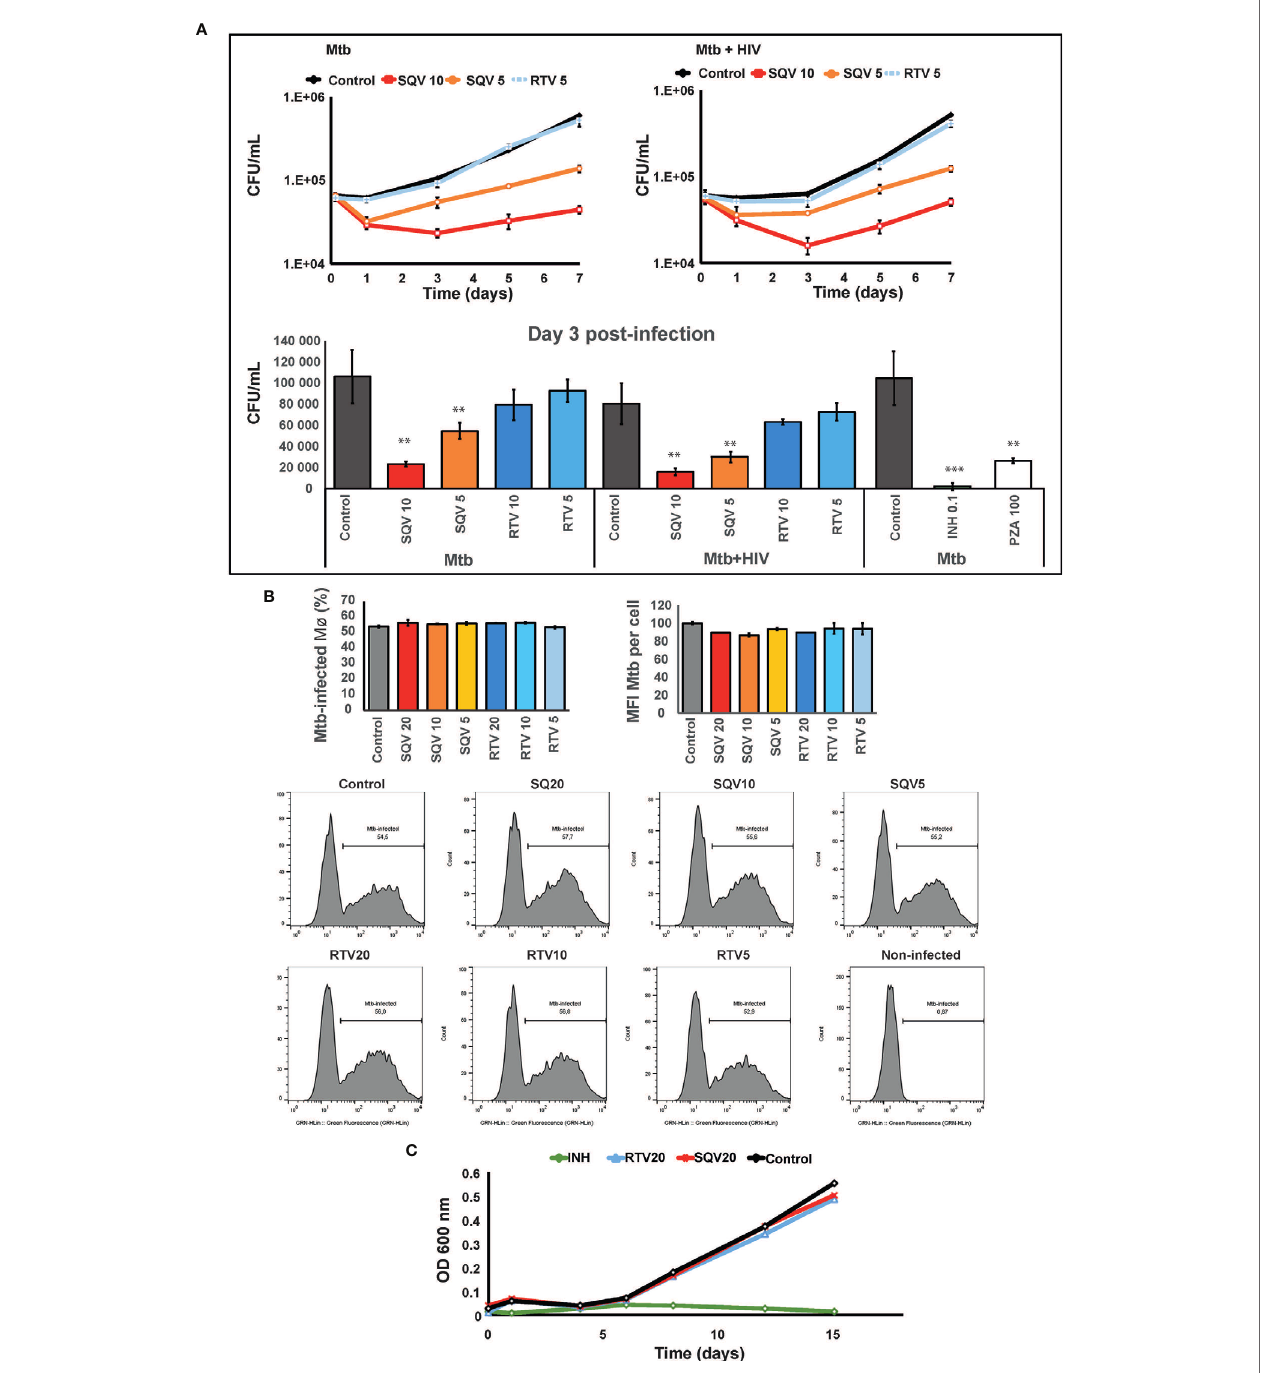
FIGURE 2 | SQV decreases the intracellular survival of Mycobacterium tuberculosis (Mtb). (A) Intracellular survival of Mtb during mono- or co-infection with HIV along 7 days of infection. Data represents colony forming units (CFU) of intracellular bacteria recovered from Mø treated with the PI or DMSO control. Culture medium was changed on day 3 p.i. without addition of fresh PIs. Values depict mean CFU representative of three biological replicates from one representative experiment performed in triplicate. Error bars depict the standard deviation ( P ** < 0.01; *** P < 0.001 relatively to control). (B) Percentage of Mø infected with Mtb and median fl uorescence intensity of Mtb per Mø were measured by fl ow cytometry in Mø pre-treated with the PIs and after 3 h of infection with GFP-expressing Mtb. Bar-plots depict the average of three biological replicates and the error bars depict the standard error. Raw values from one representative replicate are presented in the fl uorescence intensity histograms. (C) Mtb growth curves in broth medium treated with PIs and incubated for 15 days. Values represent the optical density measured at discrete time points from one representative experiment performed twice. Isoniazid (INH) was used as control for inhibition of